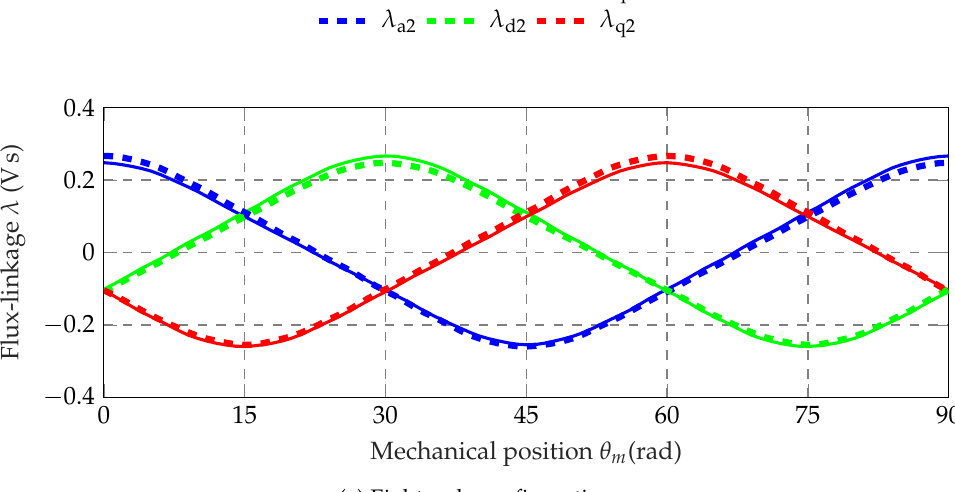
( a ) Eight-pole configuration.